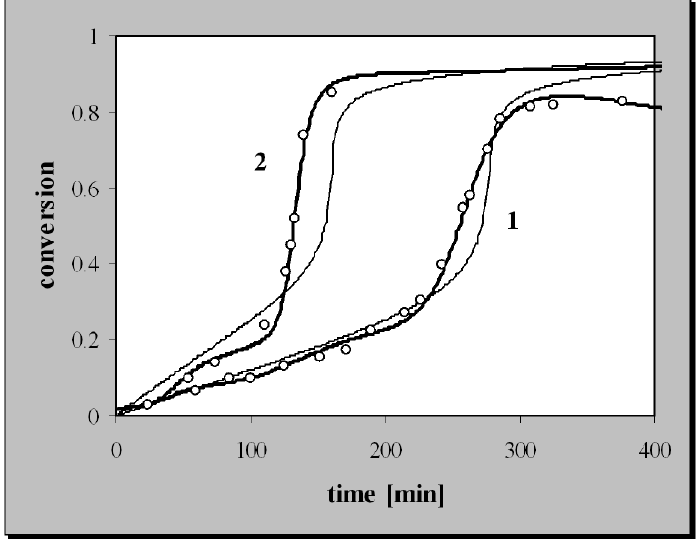
Fig. 7 Comparison between conversions obtained with mechanistic model (thin lines), neural network model (thick lines) and experimentally (o) at (1) T = 50 o C and I 0 = 20.18 mol/m 3 and (2) T = 50 o C and I 0 = 100 mol/m 3 .